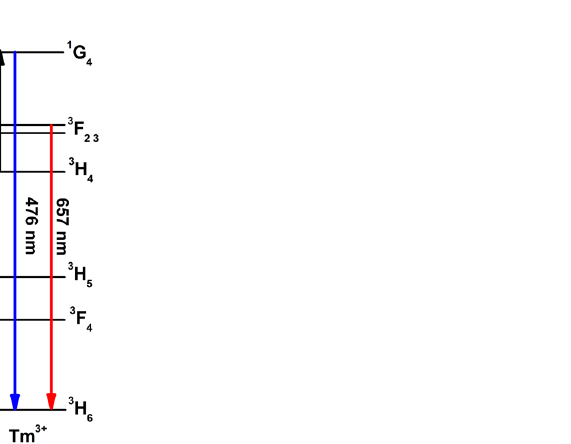
9 Scientific RepoRts | 7: 6518 | DOI:10.1038/s41598-017-05943-4